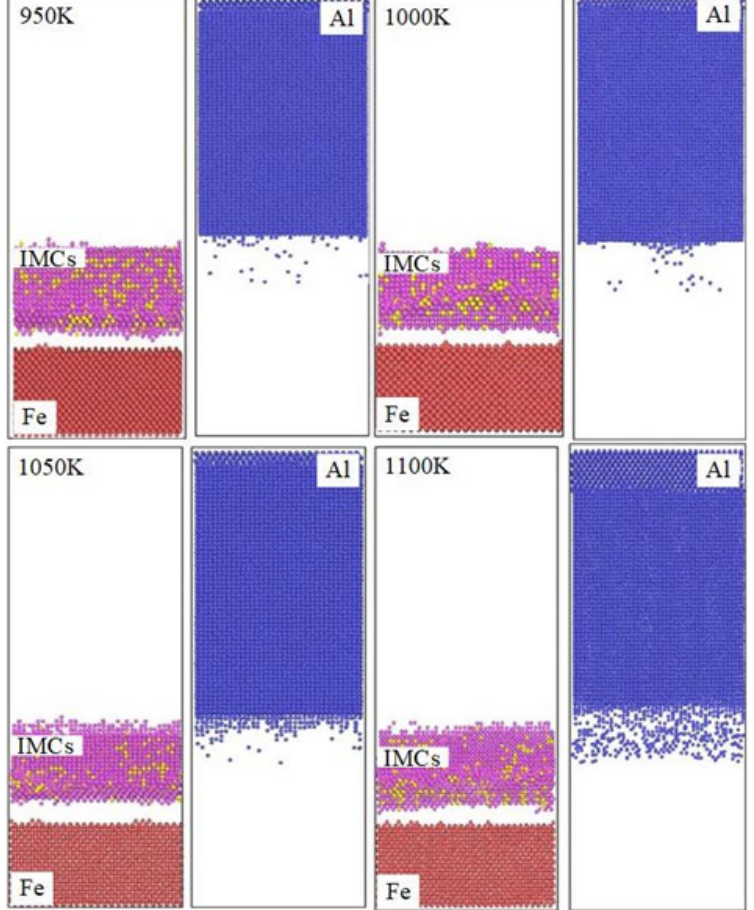
Figure 5. Mutual diffusion of Al and Fe atoms at different temperatures. The concentration of atoms in the z-axis in the interfacial system can be quantified by analyzing the atomic distribution, as shown in Figure 6. The plateau of Al and Fe